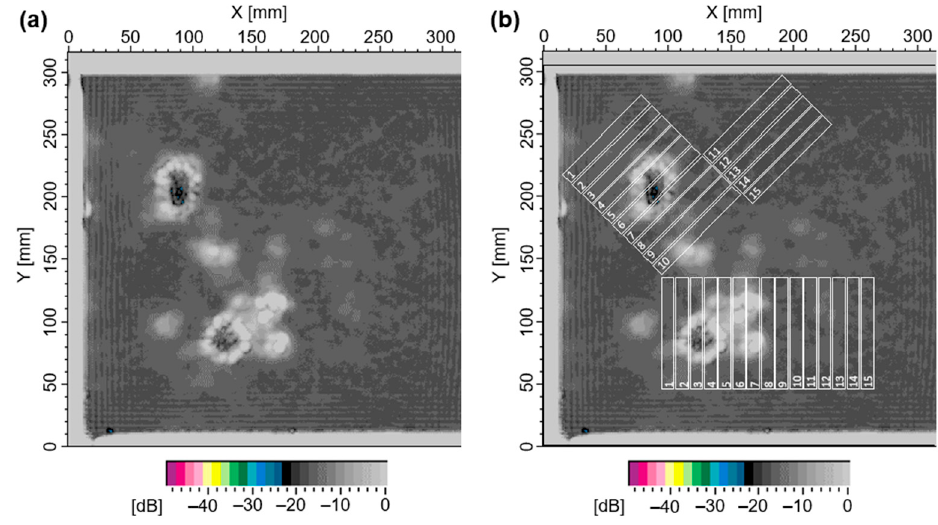
Figure 2. ( a ) C-image of the ACU-inspection with two distinct inhomogeneous plate regions; ( b ) C-image with overlaid cutting scheme for samples with fiber orientation ±45° and 0/90°.